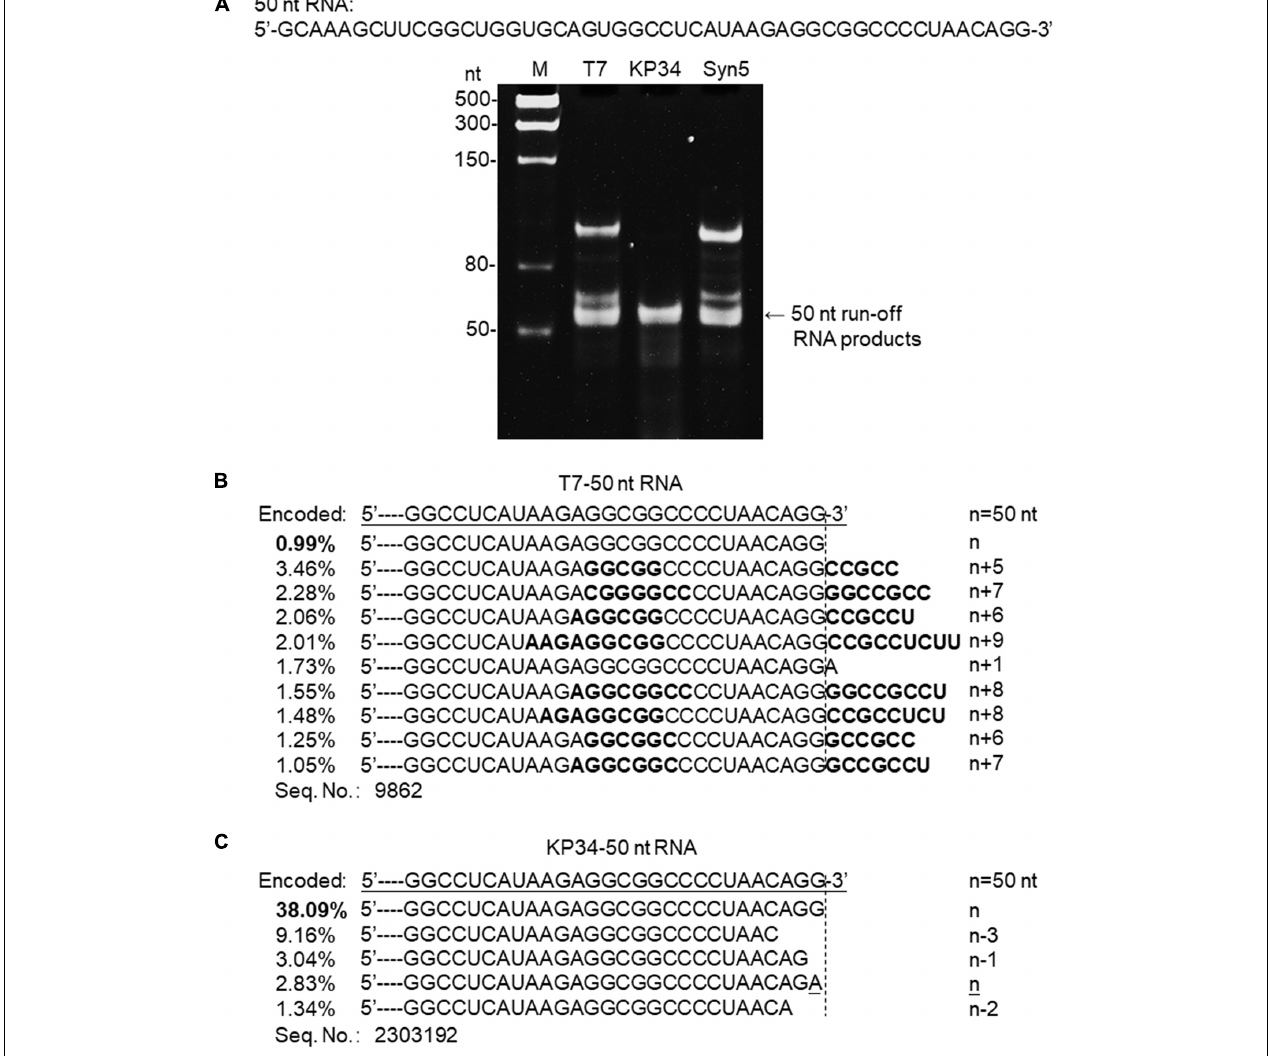
FIGURE 3 | Synthesis of a 50 nt RNA containing 3 (cid:48) hairpin structure by various RNAPs. (A) The 50 nt RNA sequence is shown at the top of the gel. The three DNA templates containing the same coding sequences for the 50 nt run-off RNA transcripts under the control of either a T7 promoter, a KP34 strong promoter, or a Syn5 promoter were incubated with 0.2 µ M T7 RNAP, 1 µ M KP34 RNAP, or 1 µ M Syn5 RNAP, respectively. Incubation with KP34 and T7 RNAP was at 37 ◦ C for 1 h and incubation with Syn5 RNAP was at 24 ◦ C for 1 h. Reaction products were separated by a 12% TBE native gel and then stained with ethidium bromide. M: ssRNA Ladder. (B) RNA-Seq analysis of the 3 (cid:48) termini of T7 RNAP transcripts. 3 (cid:48) termini of sequences with reads more than 1% of total reads were aligned and shown. Percentage of major sequences in total sequencing results are noted and percentage of the correct product is in bold. A dotted line cut indicates the precise terminus encoded by DNA template, and the number of extended nt is shown as n + x. Bold sequences indicate complementary sequences in each RNA specie resulted from extension of a possible 3 (cid:48) self-primed structure. (C) Similar as B, RNA-Seq analysis of the 3 (cid:48) termini of KP34 RNAP transcripts. Number of missing nt at the 3 (cid:48) terminus of major sequences is shown as